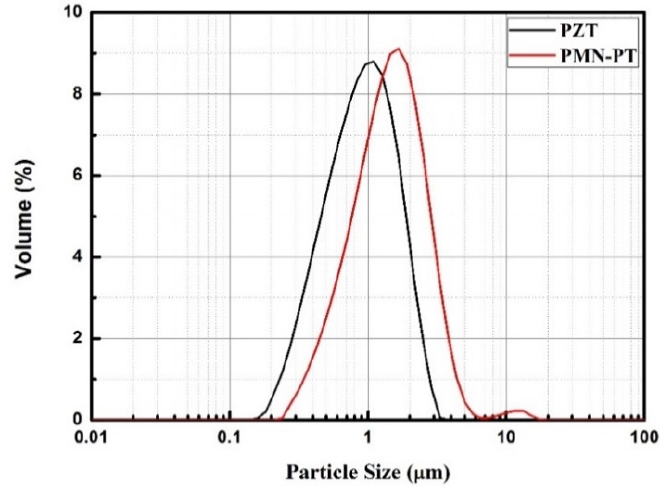
Figure 4. Particle size distribution for the PZT and PMN–PT powders.